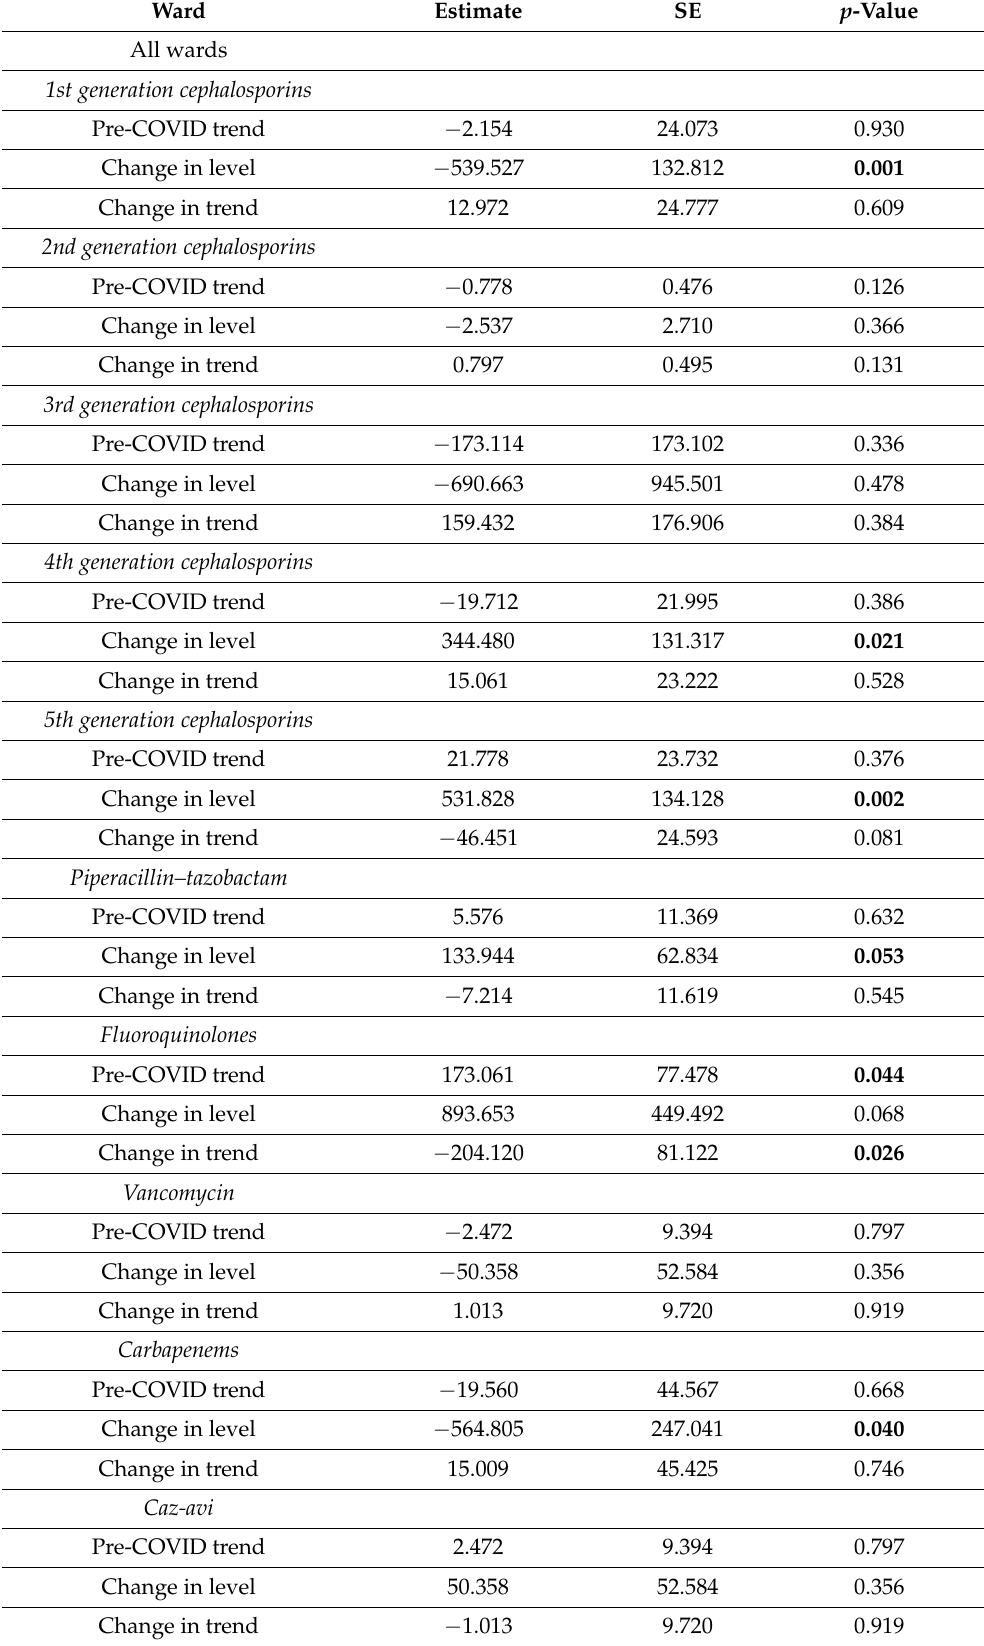
Table 3. Overall antibiotic trends in interrupted time series analysis in hospital.